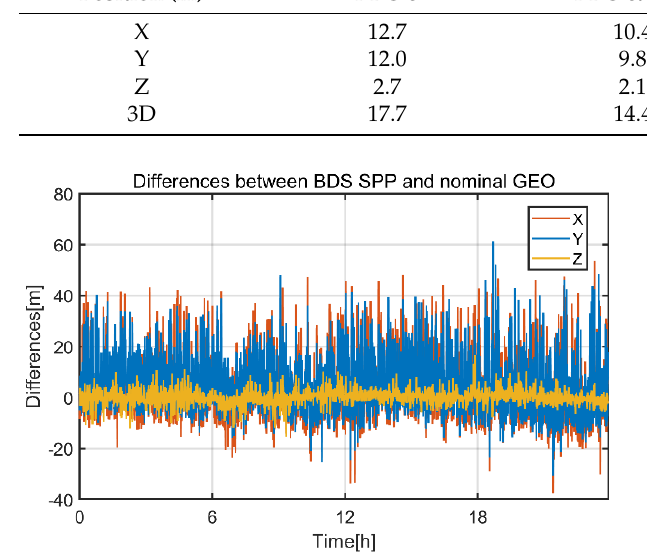
Figure 16. Differences between BDS SPP and the nominal GEO.